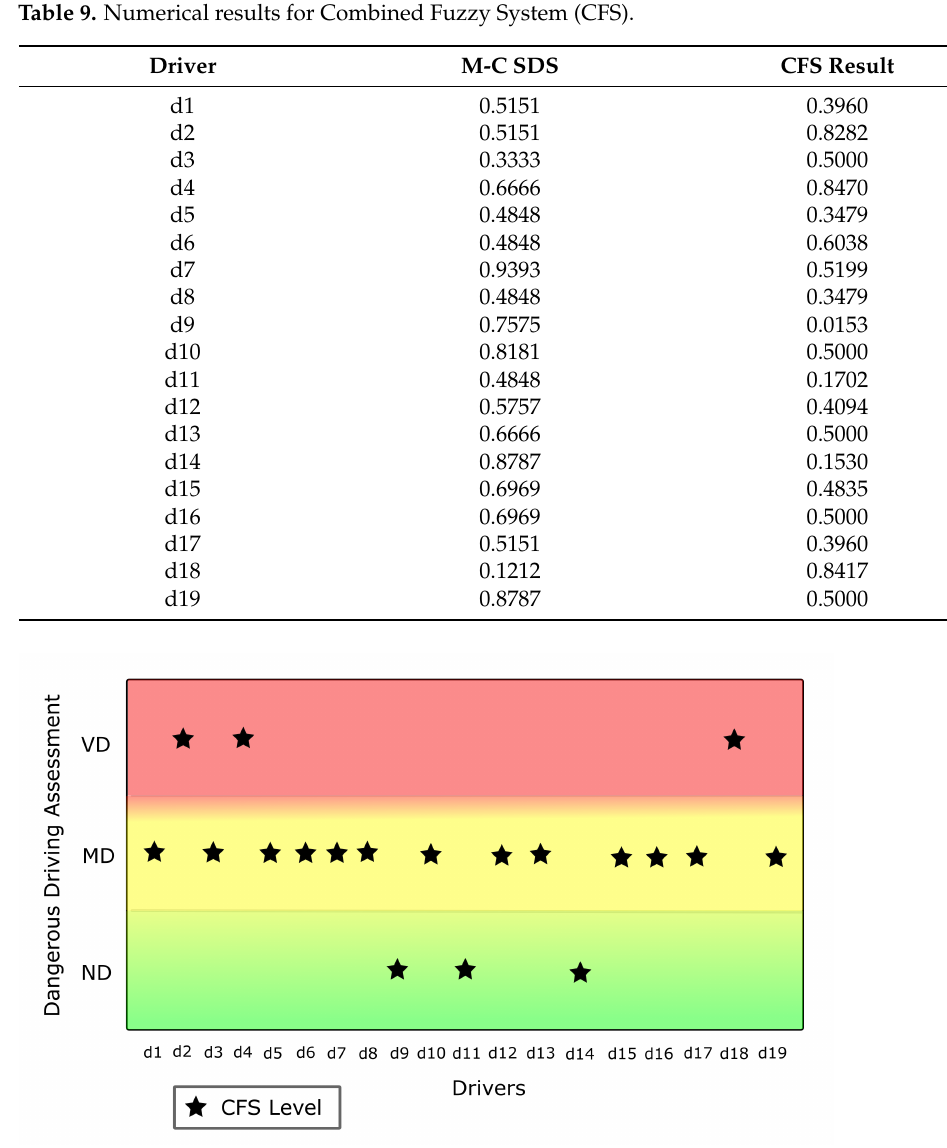
Figure 12. Classes from Combined Fuzzy System